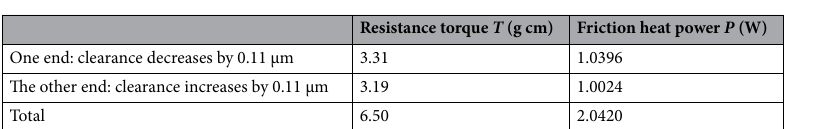
Table 1. Gas film characteristics at both ends of the rotor with 0.11 μm axial displacement.